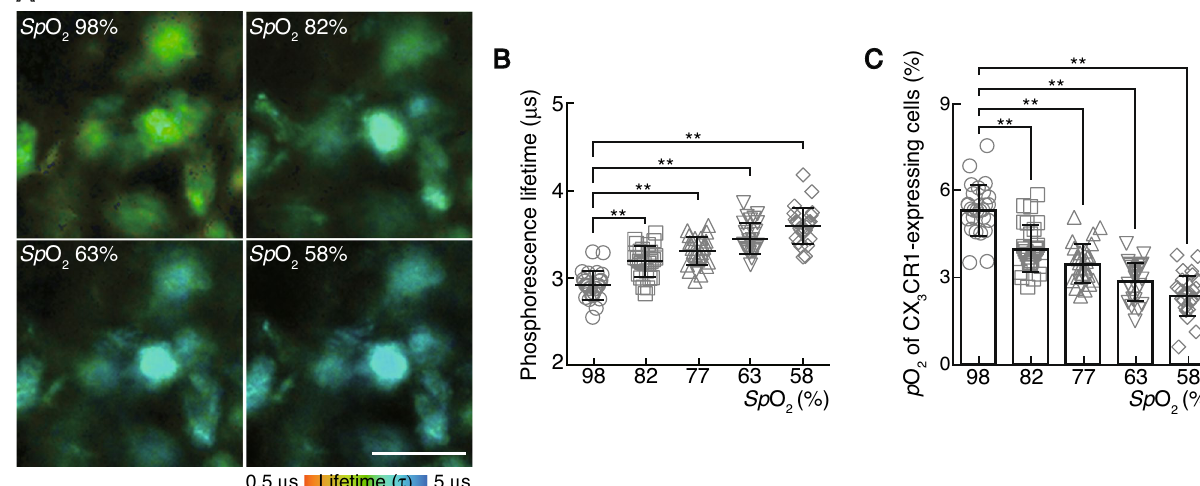
Figure 3. Measurement of the phosphorescence lifetime and the physiological range of oxygen tension ( p O 2 ) of CX 3 CR1-expressing cells in the mice during hypoxic air inhalation. ( A ) Change in the oxygen tension ( p O 2 ) of CX 3 CR1-expressing cells in mice upon exposure to various oxygen concentrations from 21 to 14% p O 2 . Magnified two-photon phosphorescence lifetime imaging microscopy (2PLIM) images of CX 3 CR1-expressing cells under different peripheral oxygen saturation values ( Sp O 2 ). Scale bar, 20 μm. ( B ) The phosphorescence lifetime of each CX 3 CR1-expressing cell in mice upon exposure to various oxygen concentration from 21 to 14% p O 2 was plotted against Sp O 2 . Data points (n = 27) represent single cells collected from four mice. Data denote the mean ± s.e.m. ** P < 0.01, one-way ANOVA with Dunnet’s multiple comparison test. ( C ) The p O 2 of each CX 3 CR1-expressing cell in mice upon exposure to various oxygen concentration from 21 to 14% p O 2 was plotted against Sp O 2 . Data points (n = 27) represent single cells collected from four mice. Data denote the mean ± s.e.m. ** P < 0.01, one-way ANOVA with Dunnett’s multiple comparison test.